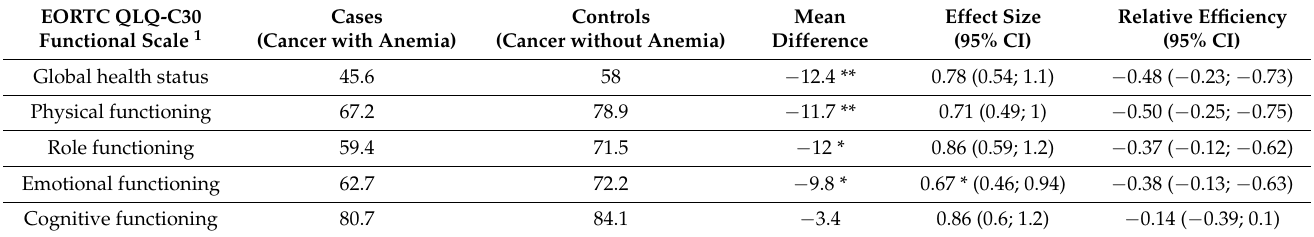
Table 2. Differences in EORTC QLQ-C30 functional and symptoms scales and EQ–5D–3L between cancer patients with and without